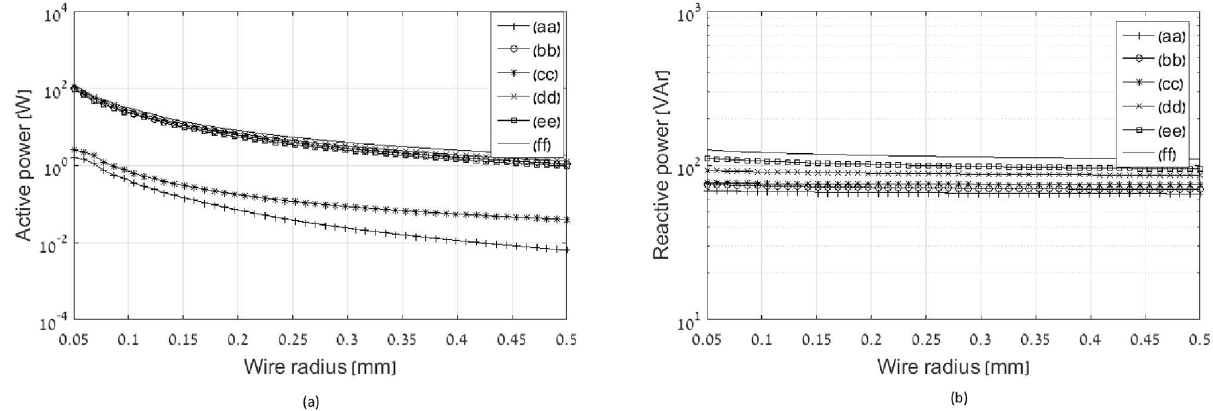
Fig 12. Active and reactive power as function of wire radius. Legendentries: (aa) optimalmulti-layer coil, (bb) optimal single layer solenoidcoil, (cc) constant current multi-layer coil, (dd) constant current singlelayer solenoidcoil, (ee) optimalflat coil, and (ff) constant current flat